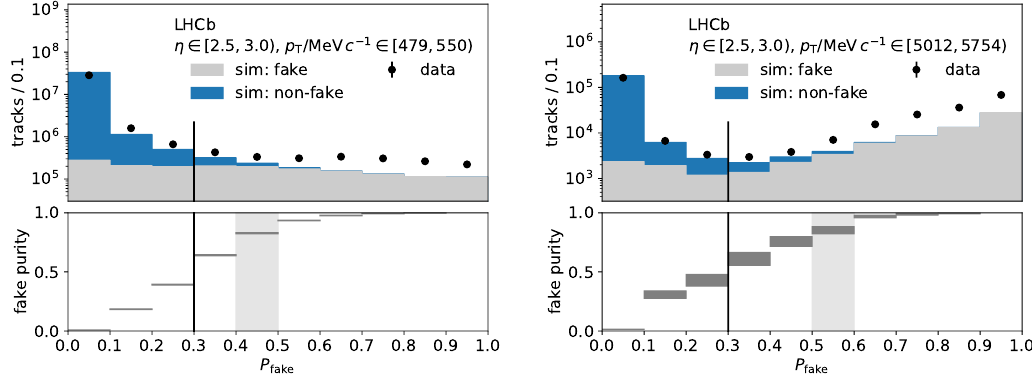
Figure 4 . Distributions of P fake in a kinematic interval (left) at low p T and (right) at high p T for the LHC fill recorded with the magnetic field pointing upwards and the simulated sample with the same magnetic-field configuration. The statistical uncertainty of the data is indicated by error bars, but they are not visible on these scales. The purity of the proxy is shown in the lower panels, where light-grey boxes represent the P fake interval selected to determine the proxy. Vertical lines indicate the threshold P fake < 0 . 3 for candidate tracks. The normalisation of the simulated sample is described in section